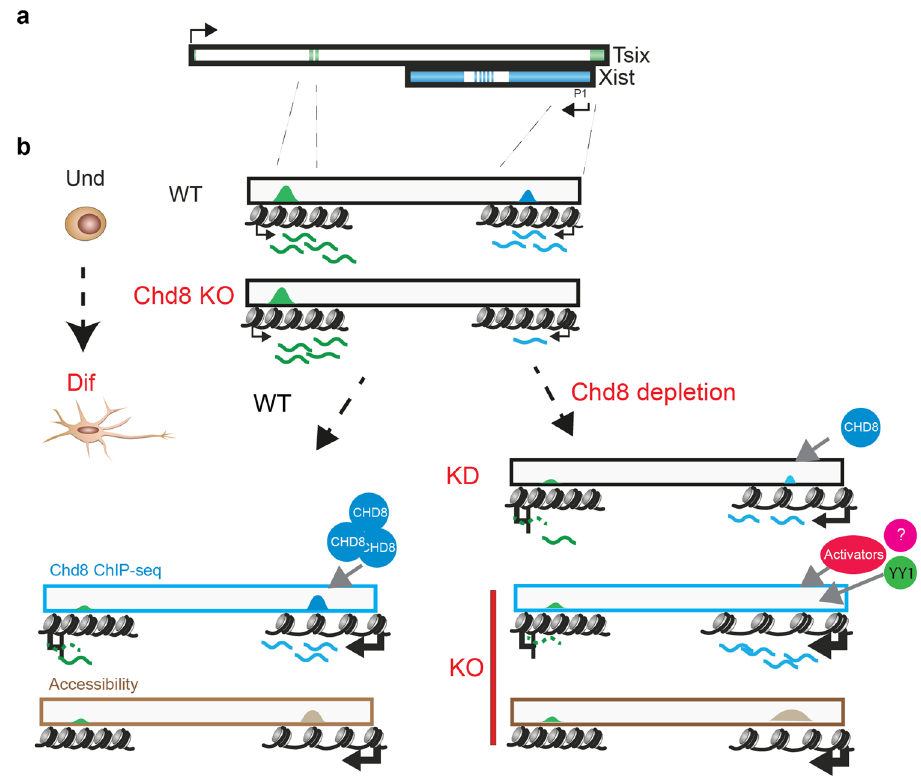
Fig. 6 Proposed model of action of Chd8 on the Xist promoter. a Schematic representation of the Xist (blue) and Tsix genes (green). b Chd8 is crucial for correct Xist expression in undifferentiated and differentiating ESCs. CHD8 is shown in light-blue; Tsix -speci fi c TF/remodelers are shown in green. Top, CHD8 localization at the Xist promoter is shown (light-blue peak). In undifferentiated conditions (Und), in the absence of CHD8, there is reduction of the basal transcription level of Xist (blue wavy lines), while Tsix transcription level is unaffected (green wavy lines). c Differentiating conditions in Chd8 KD and Chd8 KO background. Right, a mild Chd8 KD leads to a small reduction of Xist steady levels (KD). Complete and severe CHD8 depletions instead, lead to increased Xist expression and a further Tsix downregulation (blue wavy lines Xist , green wavy lines Tsix ). This condition also leads to a more-open chromatin state of the Xist regulatory regions, but not at Tsix ’ s, during differentiation (light-brown peaks). We suggest that YY1 (green circle) and/or known (red circle) and yet-to-be-identi fi ed protein (purple circle with question mark) may bind to the Xist promoter in the absence of the CHD8 protein (red arrow) and strongly activate it. Left, WT situation is